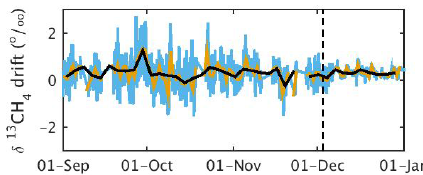
Figure 9. Low-tank methane isotopic ratio differences from known value, for the individual calibration cycles (blue), and for 1-day (red) and 3-day (black) means of the calibration cycles, for the south tower for September–December 2016. An improved calibra- tion tank sampling strategy was implemented on 3 December 2016 (indicated by the vertical dashed line). The low tank is independent of the isotopic ratio